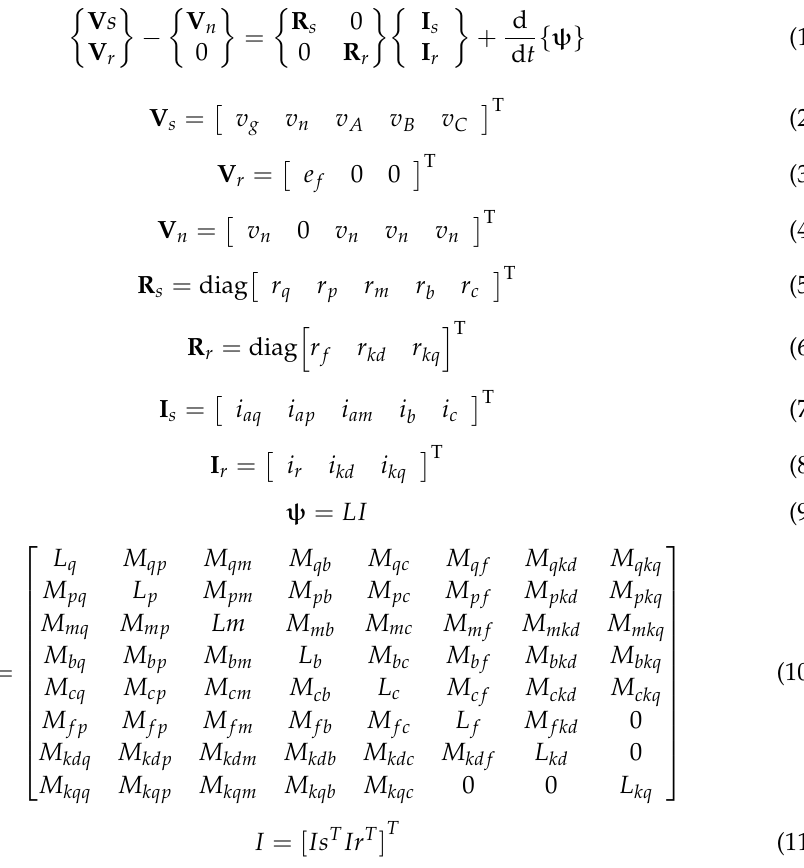
Figure 3. Quasi-distributed parameter circuit model. The stator winding potential matrix is defined as V s - V n , the potential at the neutral point is V n , the rotor loop potential matrix is V r , the electromotive force of rotor is e f , the flux linkage matrix is ψ , the stator winding resistance matrix is R s , the rotor winding resistance matrix is R r , the instantaneous value matrix of stator current is I s , and the instantaneous value matrix of rotor current is I r . The voltage equation [18]